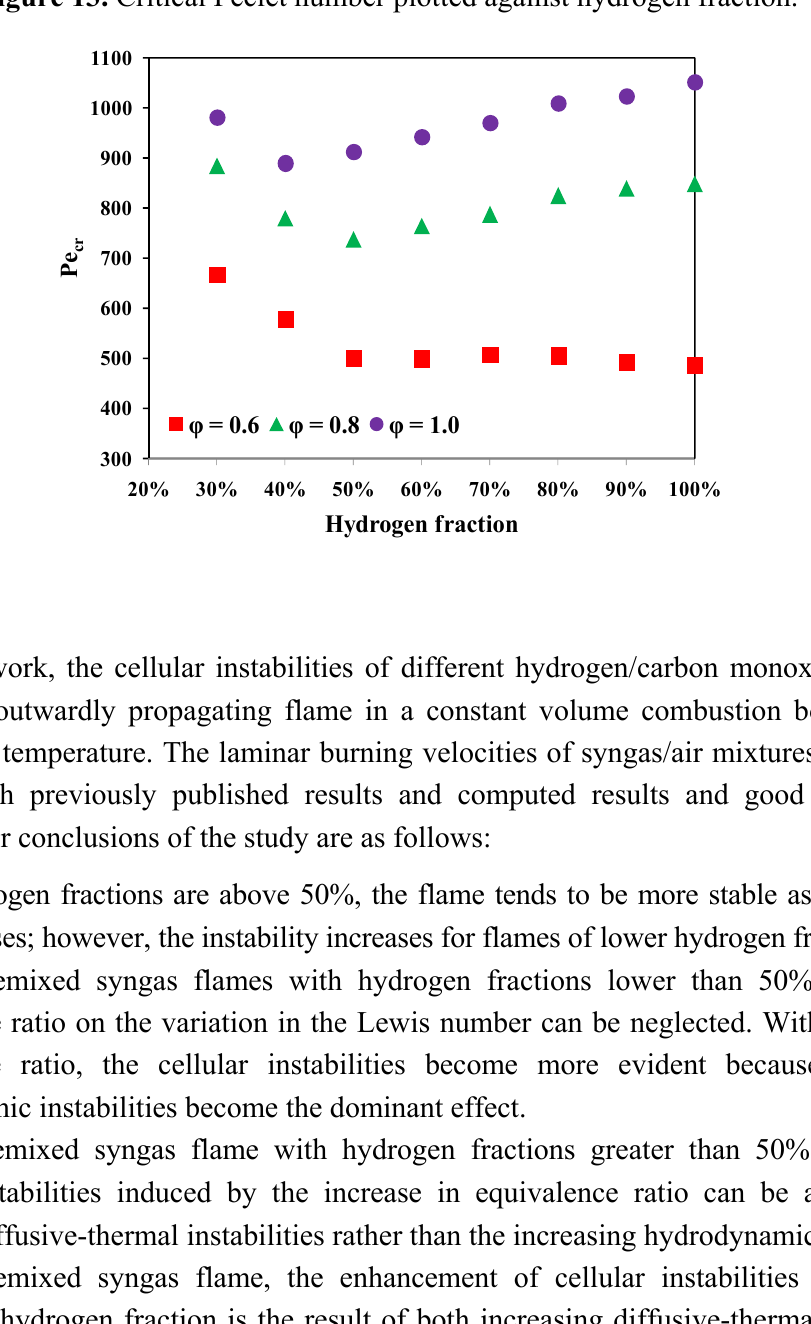
Figure 13. Critical Peclet number plotted against hydrogen